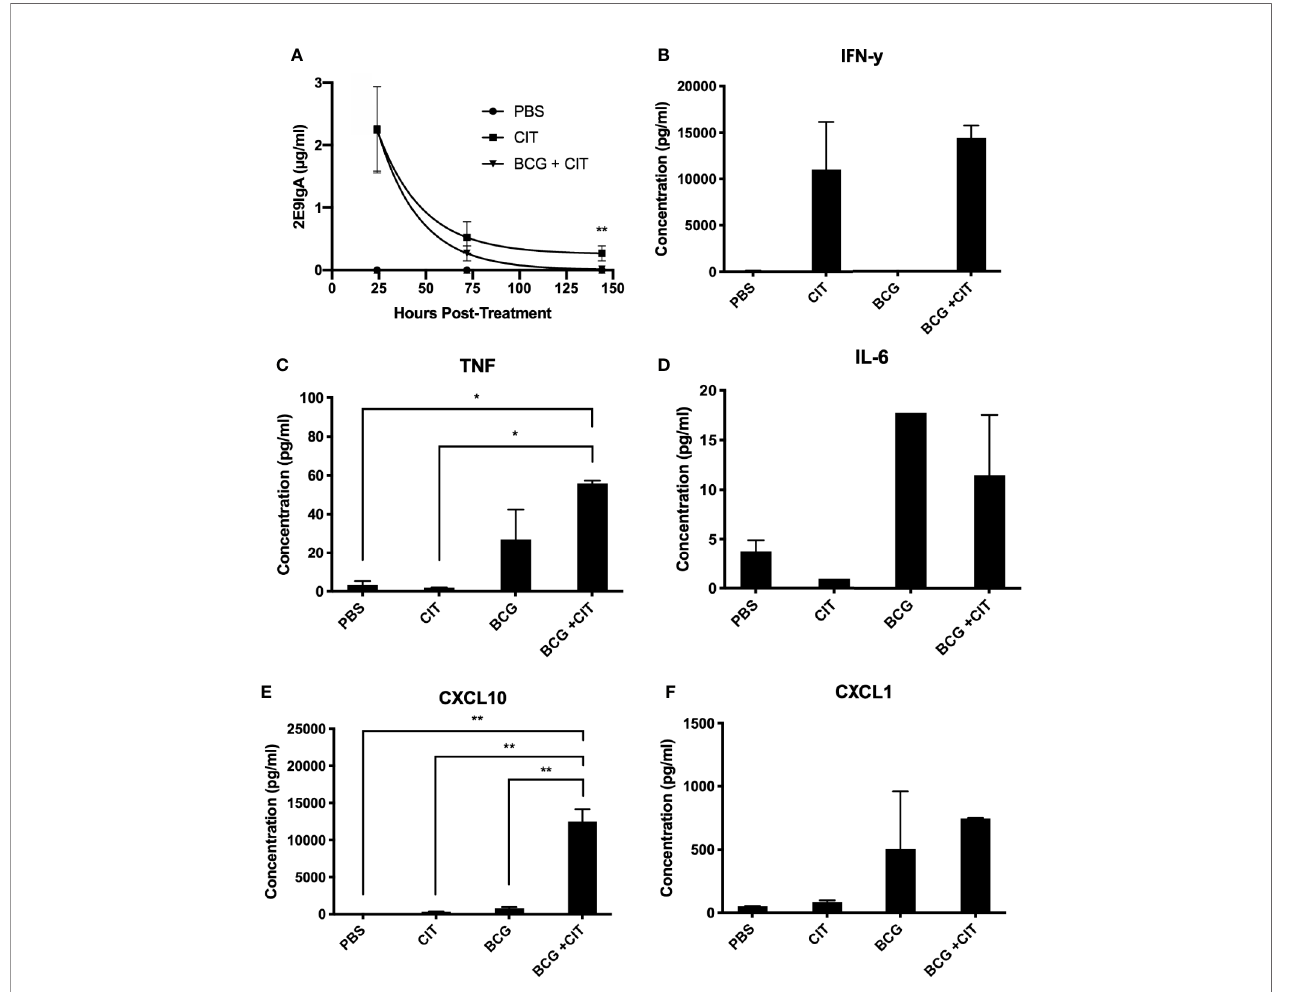
FIGURE 2 | Persistence of nasally applied IgA in mice and cytokine response to CIT in BAL. CD89 transgenic mice were treated with intranasal PBS or CIT either with or without prior intranasal BCG challenge. 2E9IgA1 titres in BAL fl uids were determined by ELISA to assess persistence of exogenous 2E9IgA1 in the lungs of mice (A) , ** indicates p ≤ 0.01 using students t test. Cytokine levels in BAL fl uids were quanti fi ed by a multiplex fl ow-cytometric assay and acquired on a BD FACSCanto to determine IFN- g (B) , TNF (C) , IL-6 (D) , CXCL10 (E) , and CXCL1 (F) responses, *p ≤ 0.05, **p ≤ 0.01 using one-way ANOVA with Tukey ’ s correction. Error bars indicate SEM of three biological